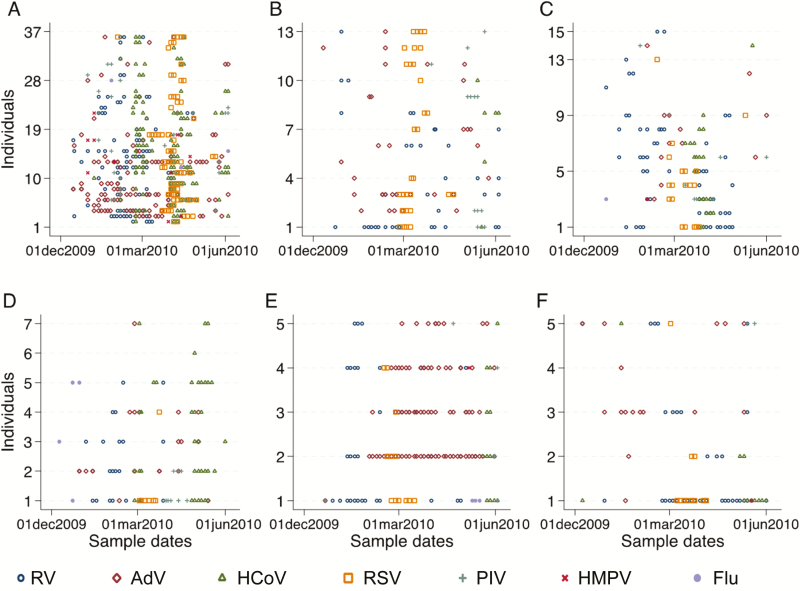
Temporal infection profile for the 6 households (A–F) showing positive samples for each member. Abbreviations: AdV, adenovirus; Flu, influenza; HCoV, human coronavirus; HMPV, human metapneumovirus; PIV, parainfluenza virus; RSV, respiratory syncytial virus; RV, rhinovirus.